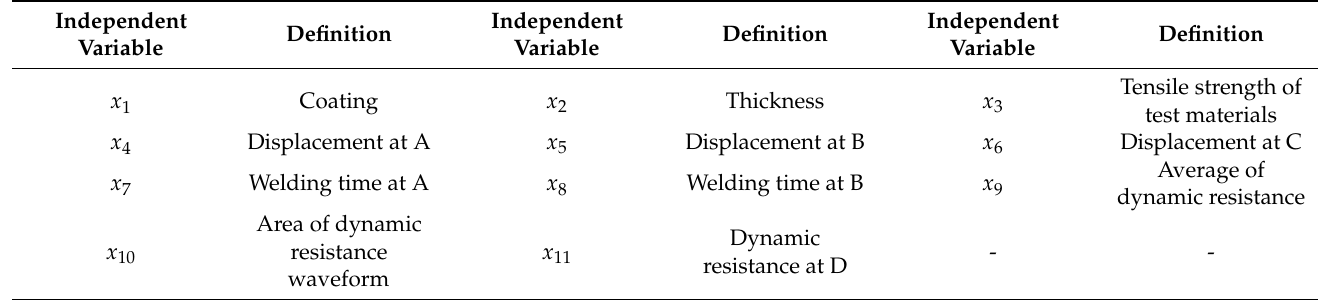
Figure 5. Electrode displacement and dynamic resistance waveforms, and cross section images according to the weld- ing time. Table 3. Definition of independent